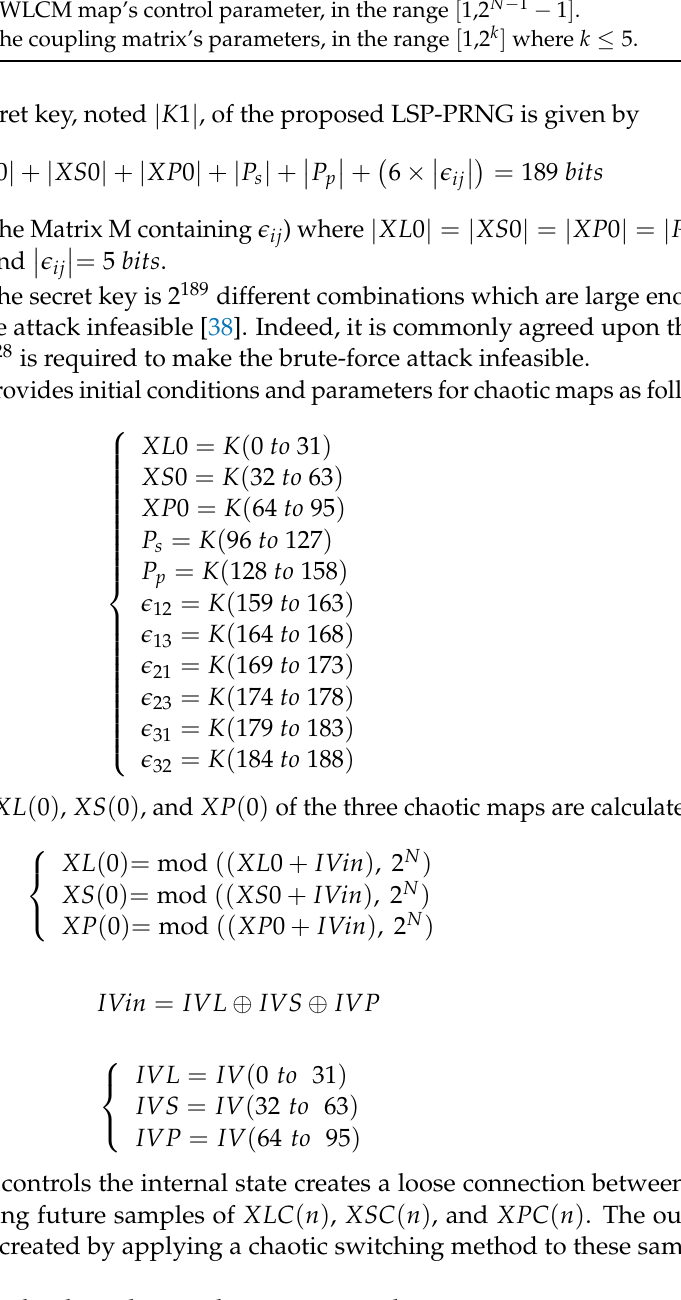
Table 3. The initial conditions and parameters that form the secret key. Symbol Definition Initial conditions of the chaotic maps: Logistic, Skew-Tent, and PWLCM XL 0, XS 0, and XP 0 respectively, ranging from 1 to 2 N − 1. P